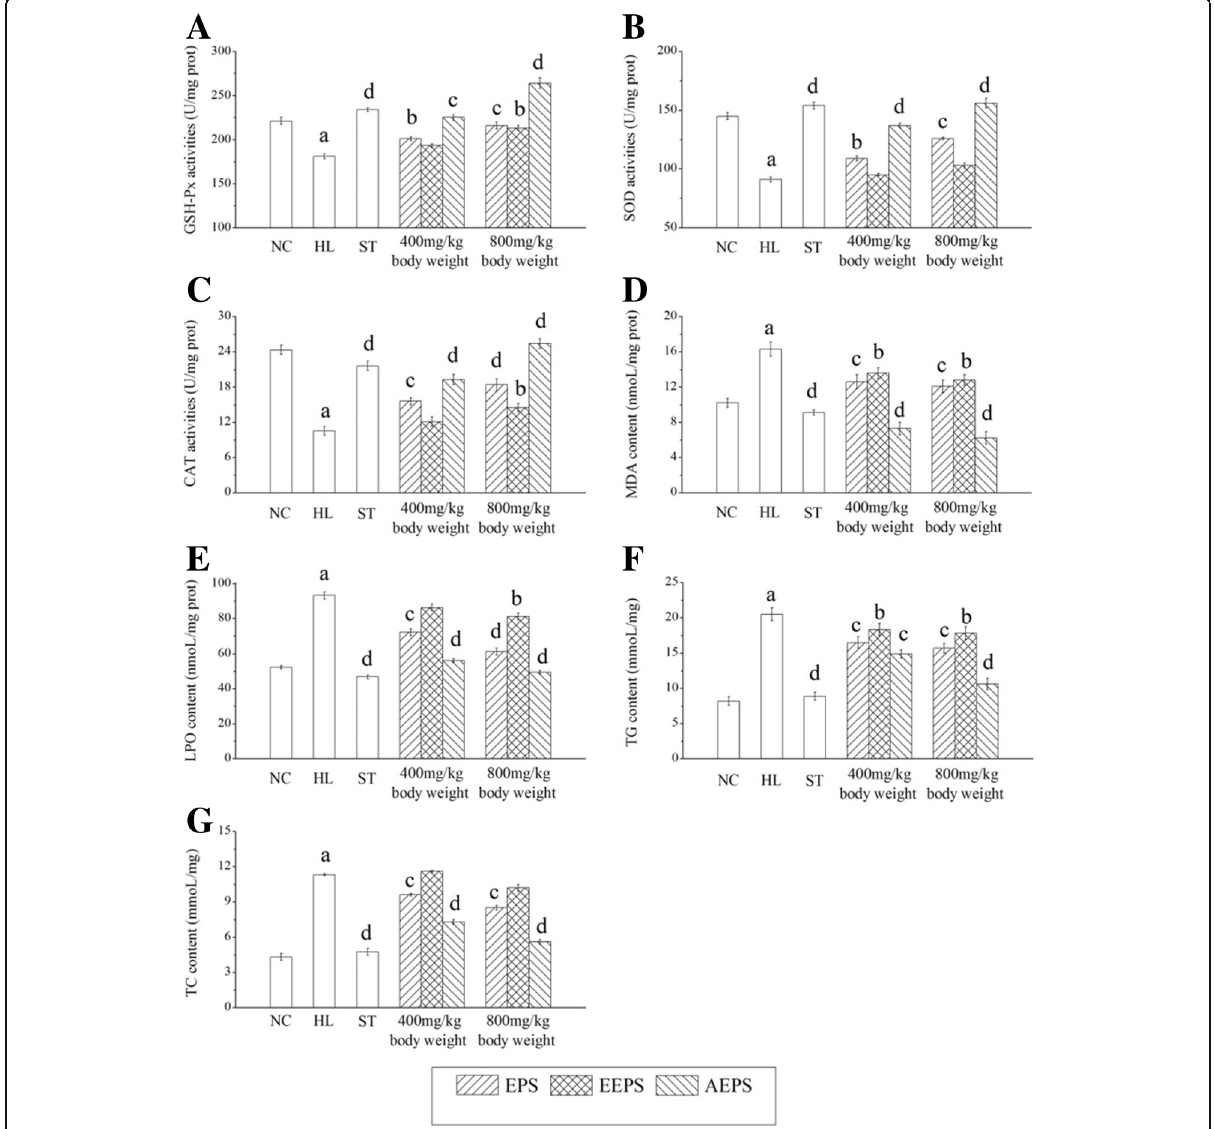
Fig. 4 Effects of EPS, EEPS and AEPS on the hepatic activities of ( a ) GSH-Px, ( b ) SOD and ( c ) CAT, as well as contents of ( d ) MDA, ( e ) LPO, ( f ) TG and ( g ) TC. The values were reported as the mean ± SD of eight mice per group. The values were reported as the mean ± SD of eight mice per group. a Significant difference compare to NC, P < 0.001. b Significant difference compare to MC, P < 0.01. c Significant difference compare to MC, P <